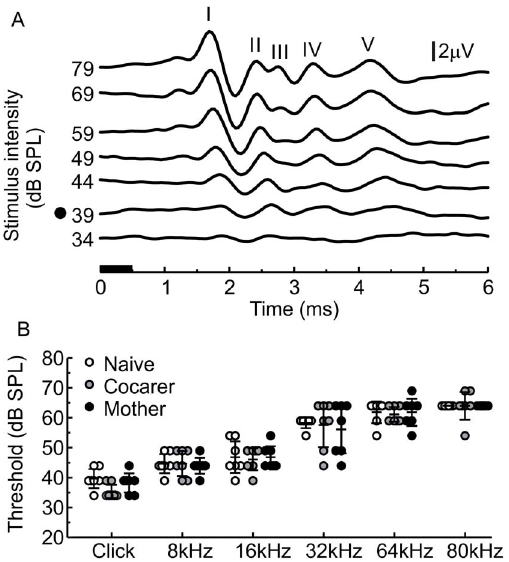
Figure 1. ABR thresholds for click and tone pip stimuli are not altered by maternal experience. A) Averaged click-evoked auditory brainstem responses (ABRs) (500 presentations per stimulus intensity). All traces are labelled with corresponding absolute stimulus intensity on the y-axis and a black dot denotes the threshold stimulus intensity. ABR peak numbers are labelled with roman numerals. The black horizontal bar on the x-axis denotes the duration of the stimulus. B) ABR thresholds for all stimuli. Dots represent ABR thresholds for individual animals with the middle horizontal bar representing the mean and error bars representing the 95% confidence